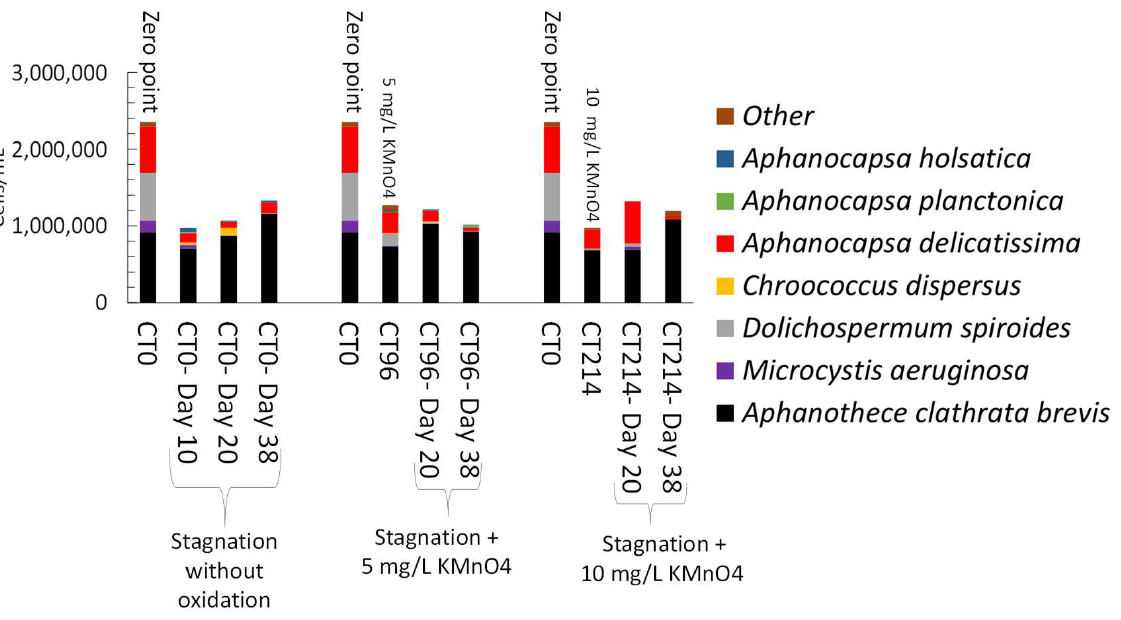
Figure 3. Fate of cyanobacterial cells (taxonomic cell counts) during sludge oxidation and stagnation in the laboratory on 17 August using 5 and 10 mg/L KMnO 4 . Zero point: Before oxidation, CT: exposure (mg · min/L), Day: stagnation day.